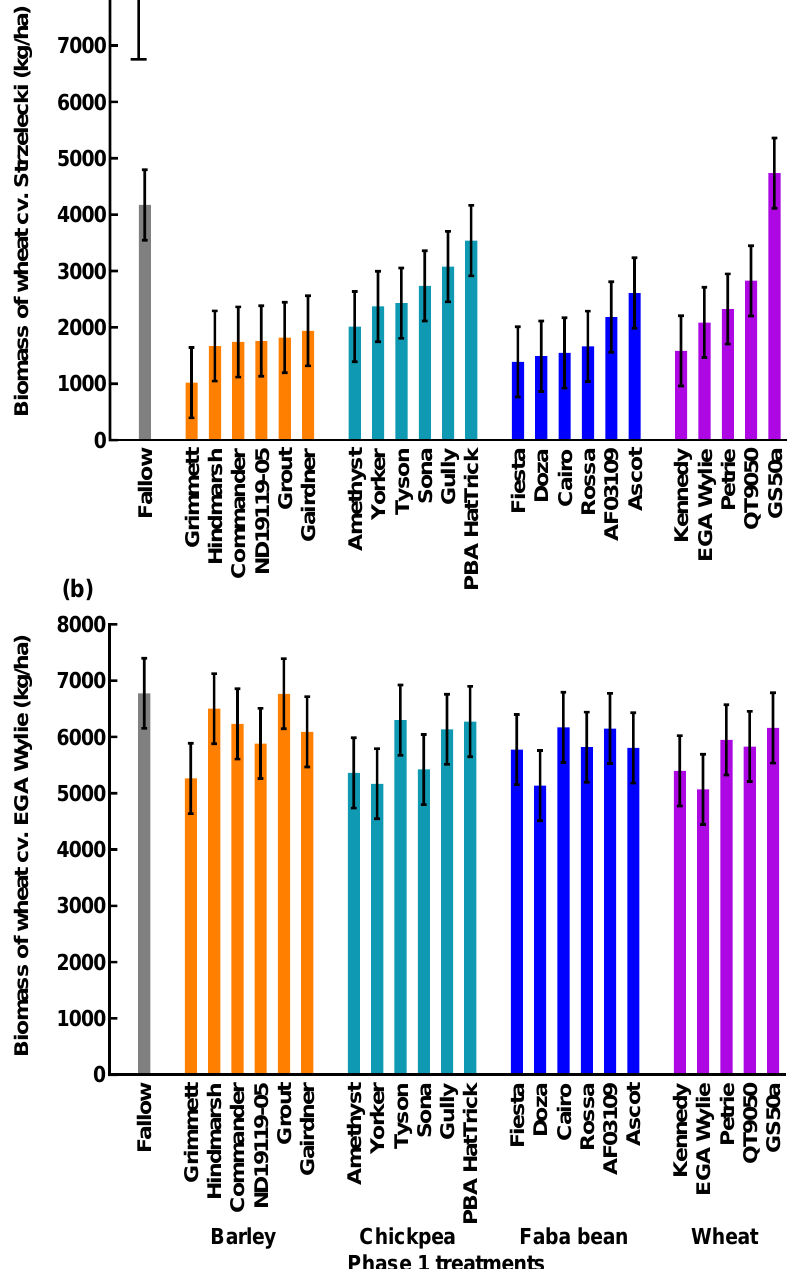
Figure 3. Plant biomass (kg/ha) of the Phase 2 wheat cvs ( a ) Strzelecki and ( b ) EGA Wylie at grain- filling after the Phase 1 crop cultivars or weed-free fallow treatment. Bar marker in ( a ) indicates l.s.d ( p = 0.05) for Phase 1 treatments × Phase 2 wheat, n = 6. Error bars indicate standard error of the mean. Cultivars of Phase 1 crops are arranged in ascending order for the biomass of the Phase 2 wheat cv. Strzelecki.